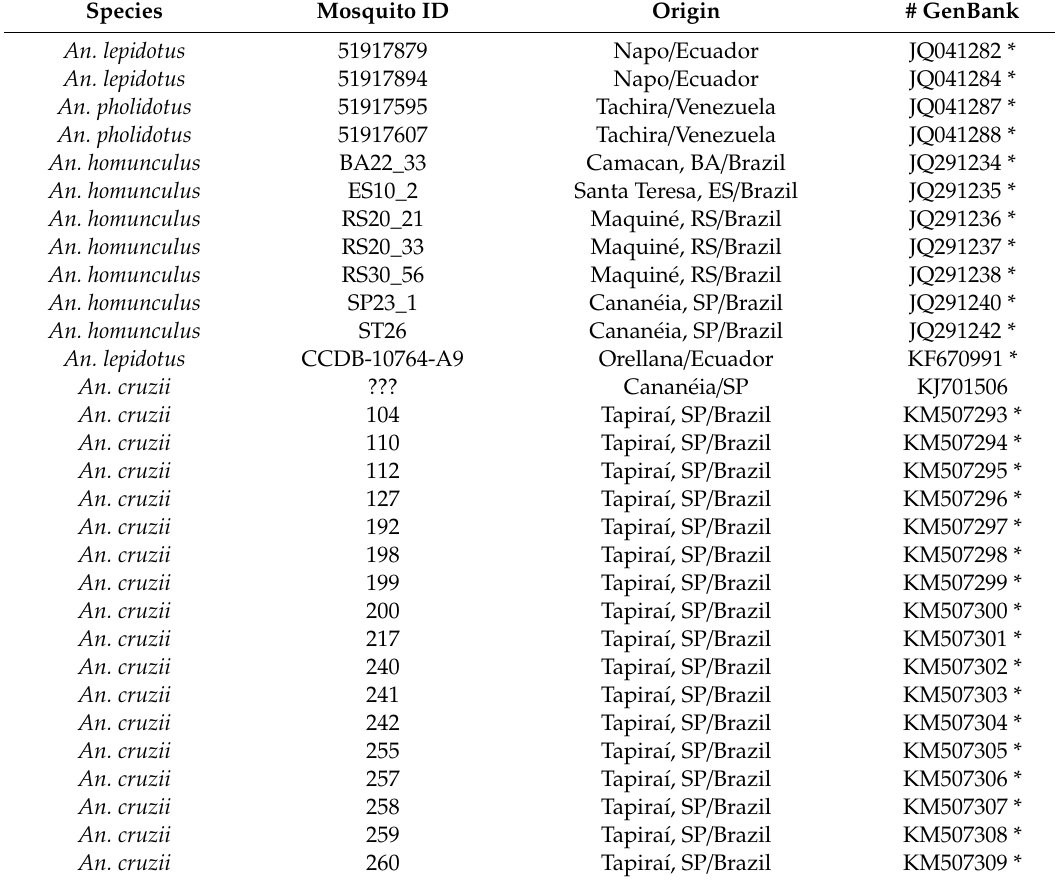
Table 3. GenBank accession numbers of the reference mosquitoes used in the